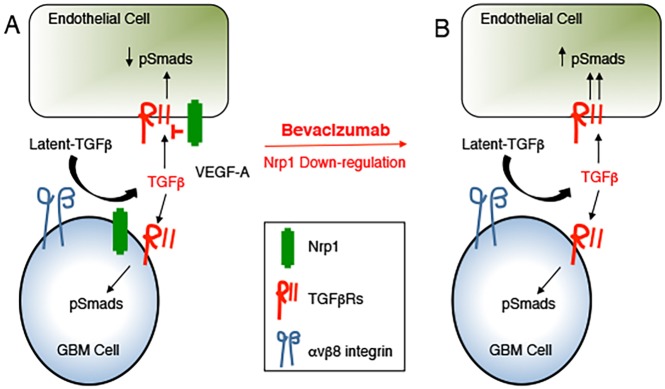
A model for Nrp1-dependent regulation of TGFβ signaling in GBM.(A); Nrp1 is expressed in GBM cells, where it along with canonical TGFβ receptors, serves as a co-receptor for TGFβs. Nrp1 enhances canonical TGFβ receptor signaling in GBM cells. In addition, Nrp1 in GBM cells can influence TGFβ receptor signaling in vascular endothelial cells and probably other cells in the tumor microenvironment. Nrp1 can also regulate VEGF-A signaling in GBM cells and in endothelial cells of the tumor microenvironment. (B); Targeting the VEGF-A pathway with bevacizumab disrupts the Nrp1-dependent balance in VEGF-A versus TGFβ signaling pathway by down-regulating Nrp1 expression In GBM cells, thus promoting neovascularization and tumor recurrence in response to VEGF-A neutralization.